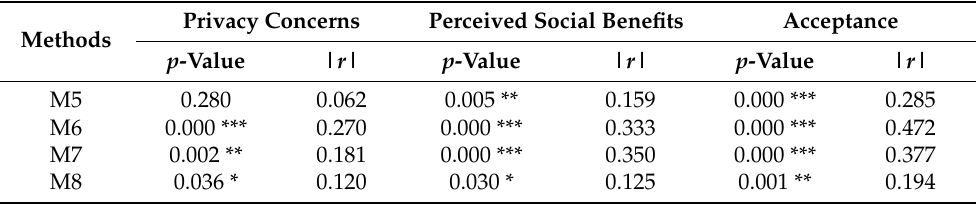
Table 7. Mann–Whitney test results for the four self-quarantine monitoring methods (comparison between the U.S. and South Korea). Methods